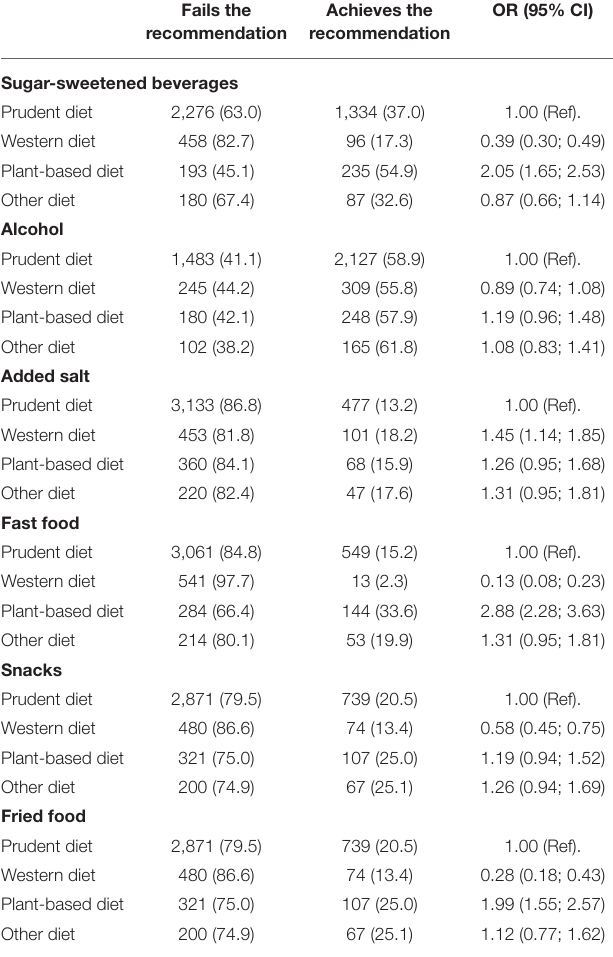
TABLE 4 | Achievement of unhealthy food groups recommendations and dietary